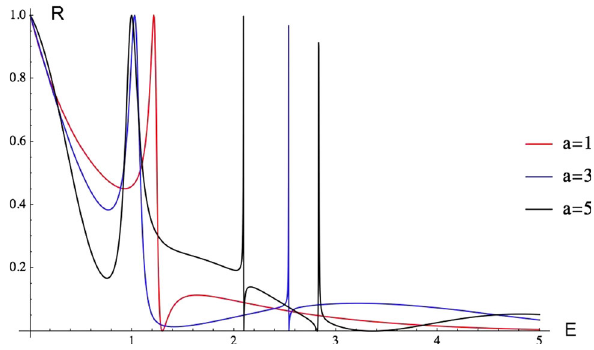
Fig. 8 Reflection coefficient versus energy